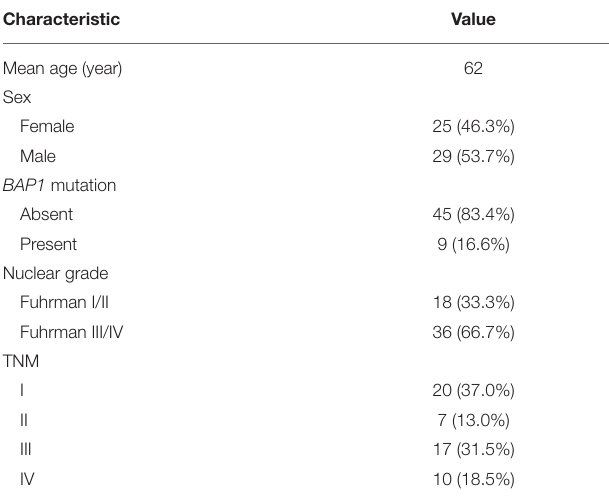
TABLE 1 | Demographic and clinical characteristics of